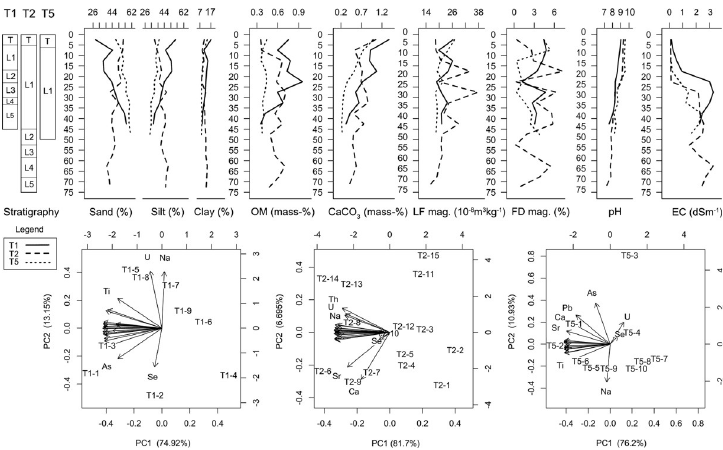
Fig 6. Results of geoarchaeological analysis. (Note: 1. In the graph of the stratigraphic sections, letter T refers to topsoil, while letter L refers to Layer. 2. In the second row of graphs, the overlapping element names were omitted in the scatter plot of the PCA